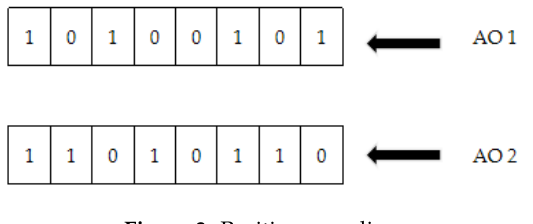
Figure 3. Position encoding.